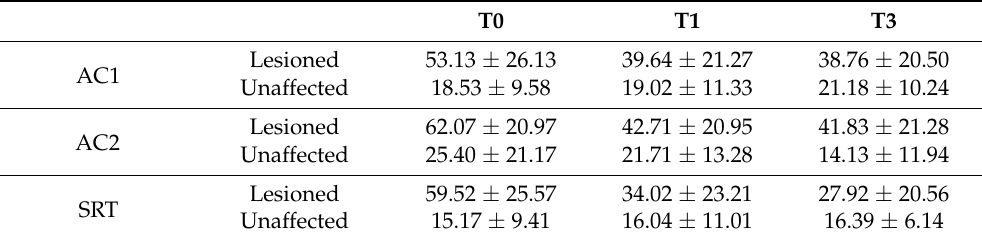
Table 2. Audiometric results of hearing thresholds (dB HL) of the lesioned and unaffected ears at pretreatment (T0), 1 month after treatment (T1) and 3 months after treatment (T3). AC1 = mean air-conduction threshold at 0.5, 1, 2 and 4 kHz; AC2 = mean air-conduction threshold at 0.5, 1, 2, 4 and 8 kHz; SRT = speech recognition threshold.